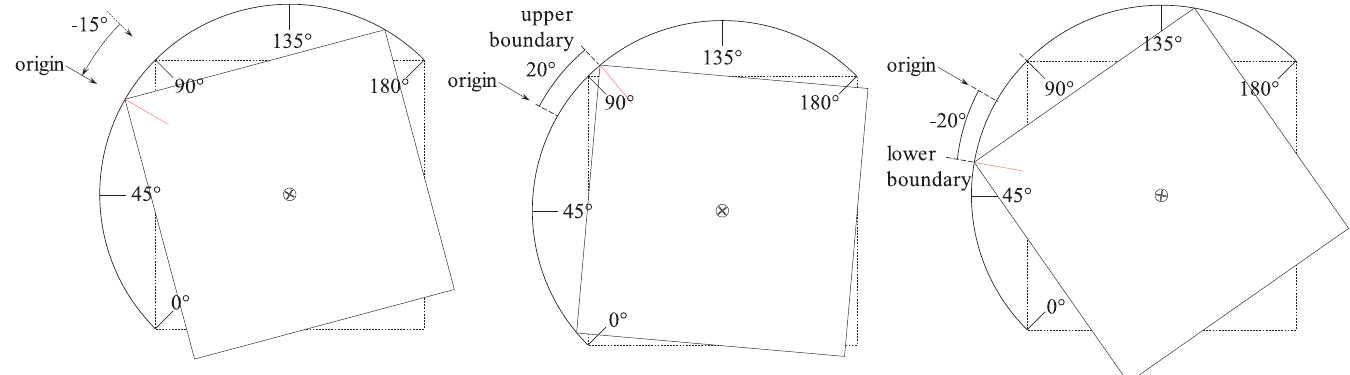
Fig 6. Angular amplitude of the cube. The amplitude,the third parameterfrom the child robot, determines the deflectionfrom the originpositionin either direction.The front and rear cubes can have differentvaluesfor their origins,definedas parameters 4 and 5, respectively.In the figure, the originis 90˚-15˚= 75˚, whilethe amplitudeis